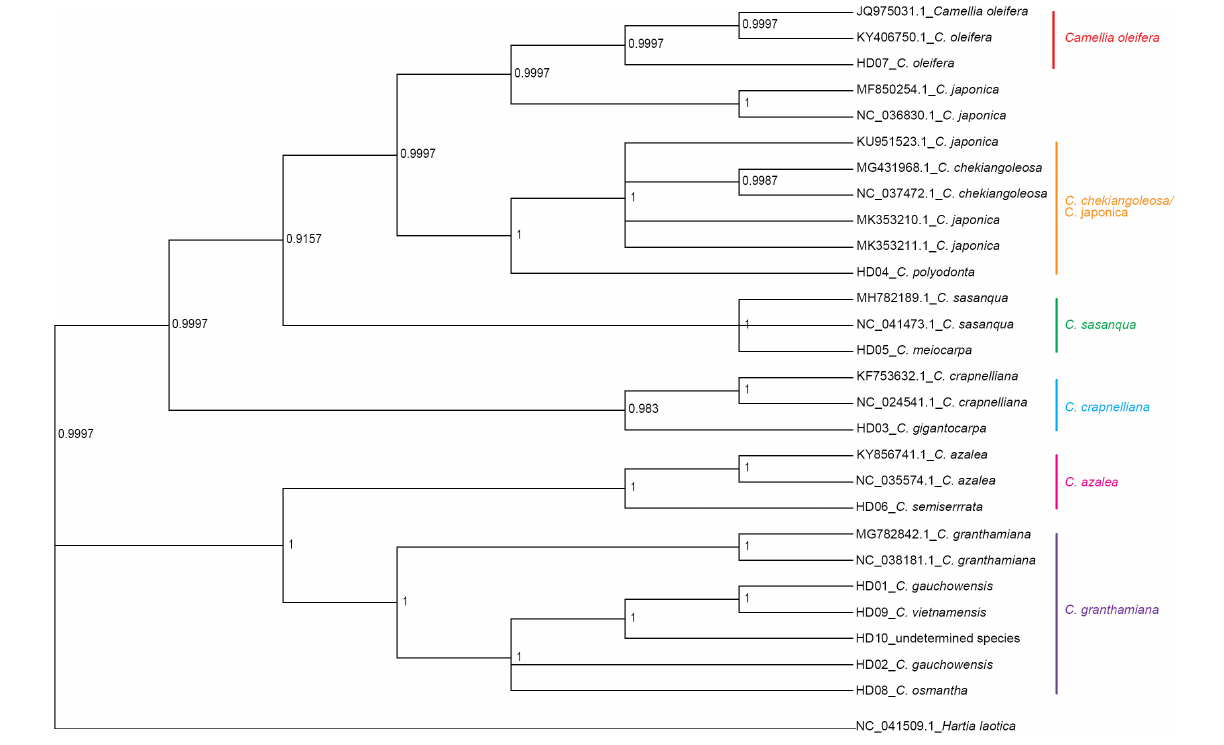
IR, LSC and SSC lengths were 577 kb, 222 kb, 433 kb, and 770